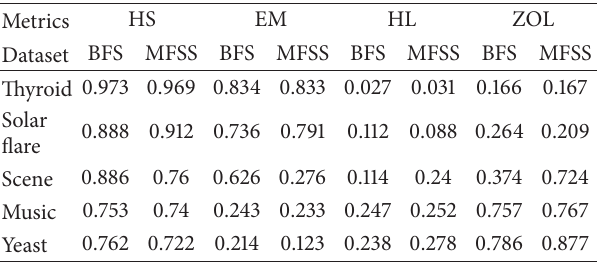
Table 5: Evaluation metrics for IBk algorithm.